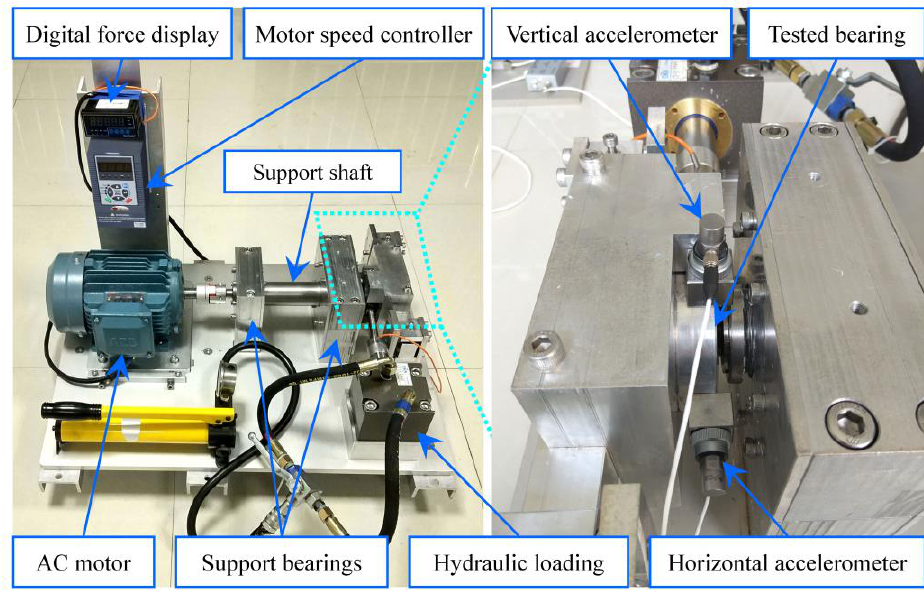
Figure 8. Bearing testbed. T le 1. Parameters of Bearing 2_1 and Bearing